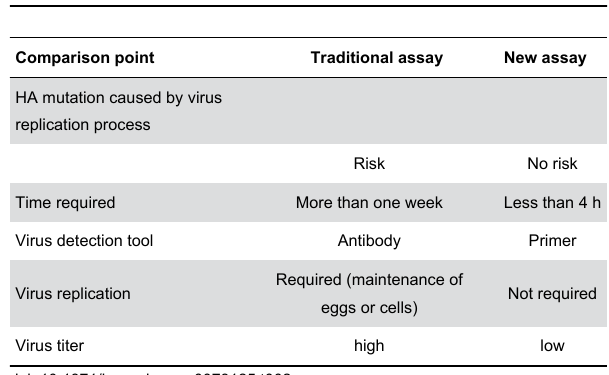
Table 2. Valuable advantages of new assay compared to traditional